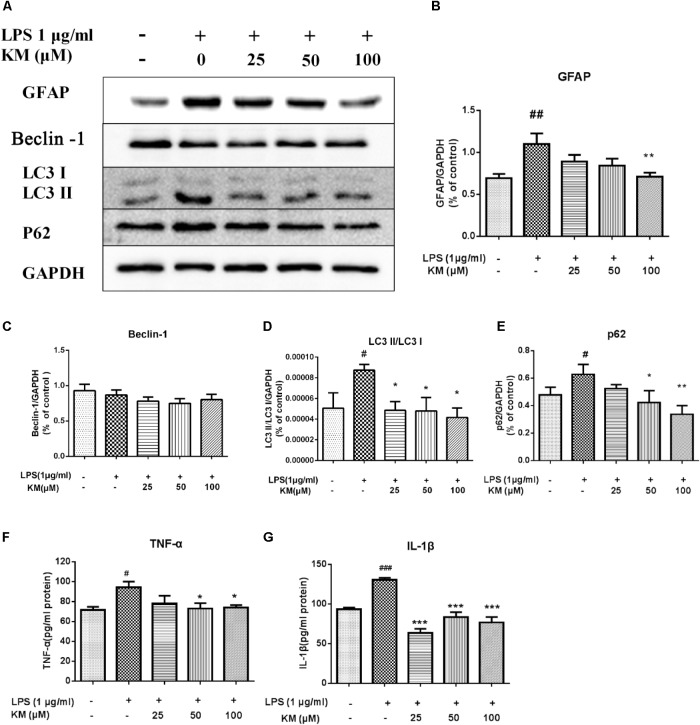
Koumine (KM) enhances LPS-induced astrocyte autophagy and attenuates astrocyte activation, as well as inflammation response in LPS-exposed primary astrocytes. Cultured astrocytes were exposed to koumine (0, 25, 50, or 100 μM) for 12 h prior to exposure to LPS for an additional 24 h before testing. Astrocytes in the control group were incubated with standard culture medium lacking koumine and LPS. Western blot (A) and densitometric quantification of GFAP (B), Beclin 1 (C), LC3-I/LC3-II (D), P62 (E), and GAPDH were performed in LPS-exposed astrocytes. Elisa were performed to explore the LPS-induced production of TNF-α (F) and IL-1β (G) in cultured astrocytes. Data are presented as the mean ± SEM. of three independent experiments. ###P < 0.001, ##P < 0.01, and #P < 0.05 compared with the control group. ∗∗∗P < 0.001, ∗∗P < 0.01, and ∗P < 0.05 compared with the LPS group, as determined by one-way ANOVA followed by the LSD test.